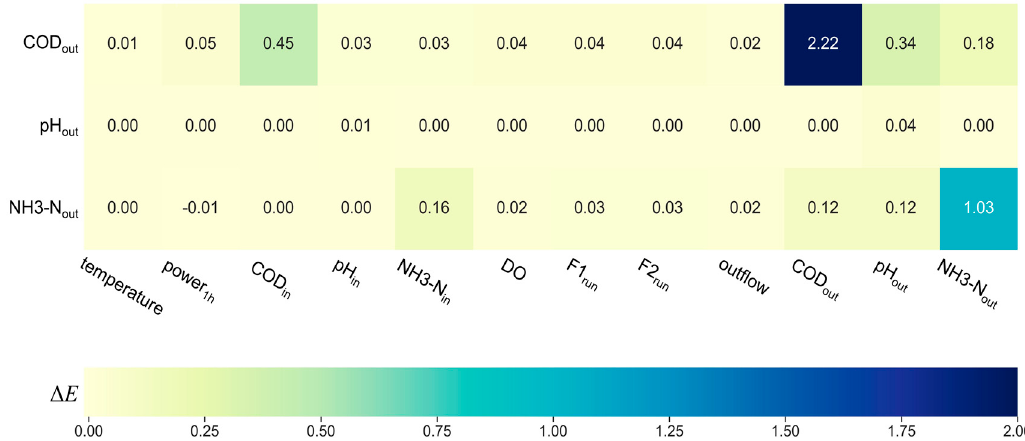
Figure 8. The chart of water quality characteristics in the ablation experiment. The Y-axis is the output features of the LMPNet model, and the X-axis is the input features that were deleted, respectively. The value in the graph is the increase in the output error ( ∆ E ) after ignoring the corresponding feature, and the larger the value indicates that the input feature is more important to the prediction of the output feature.